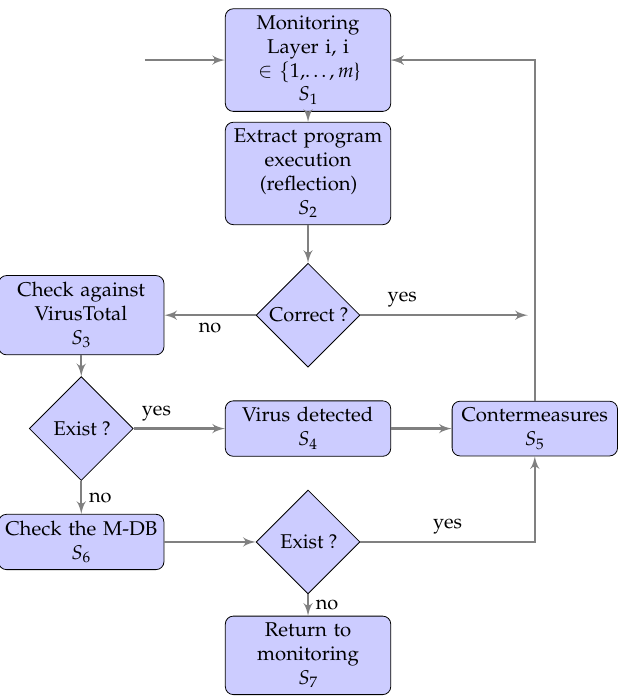
Figure 9. Detection and Reaction model